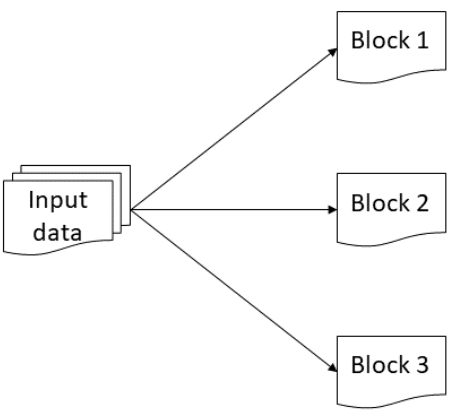
Figure 6. Map function, data entry, and block generation.